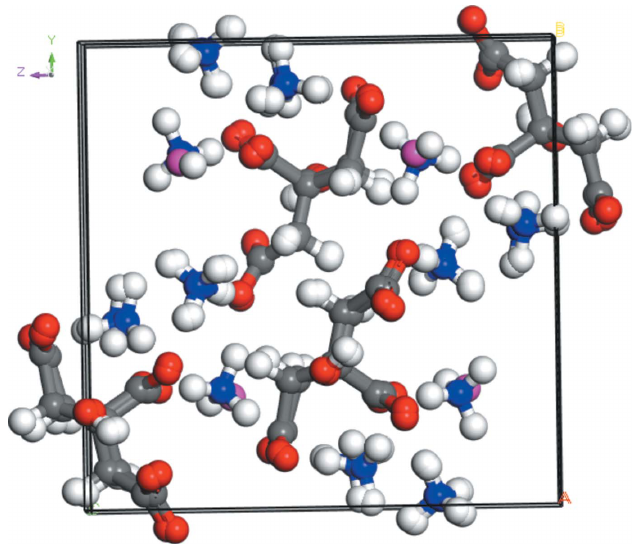
Figure 4 Overlay of the crystal structures of diammonium potassium citrate and triammonium citrate, showing that they are isostructural.